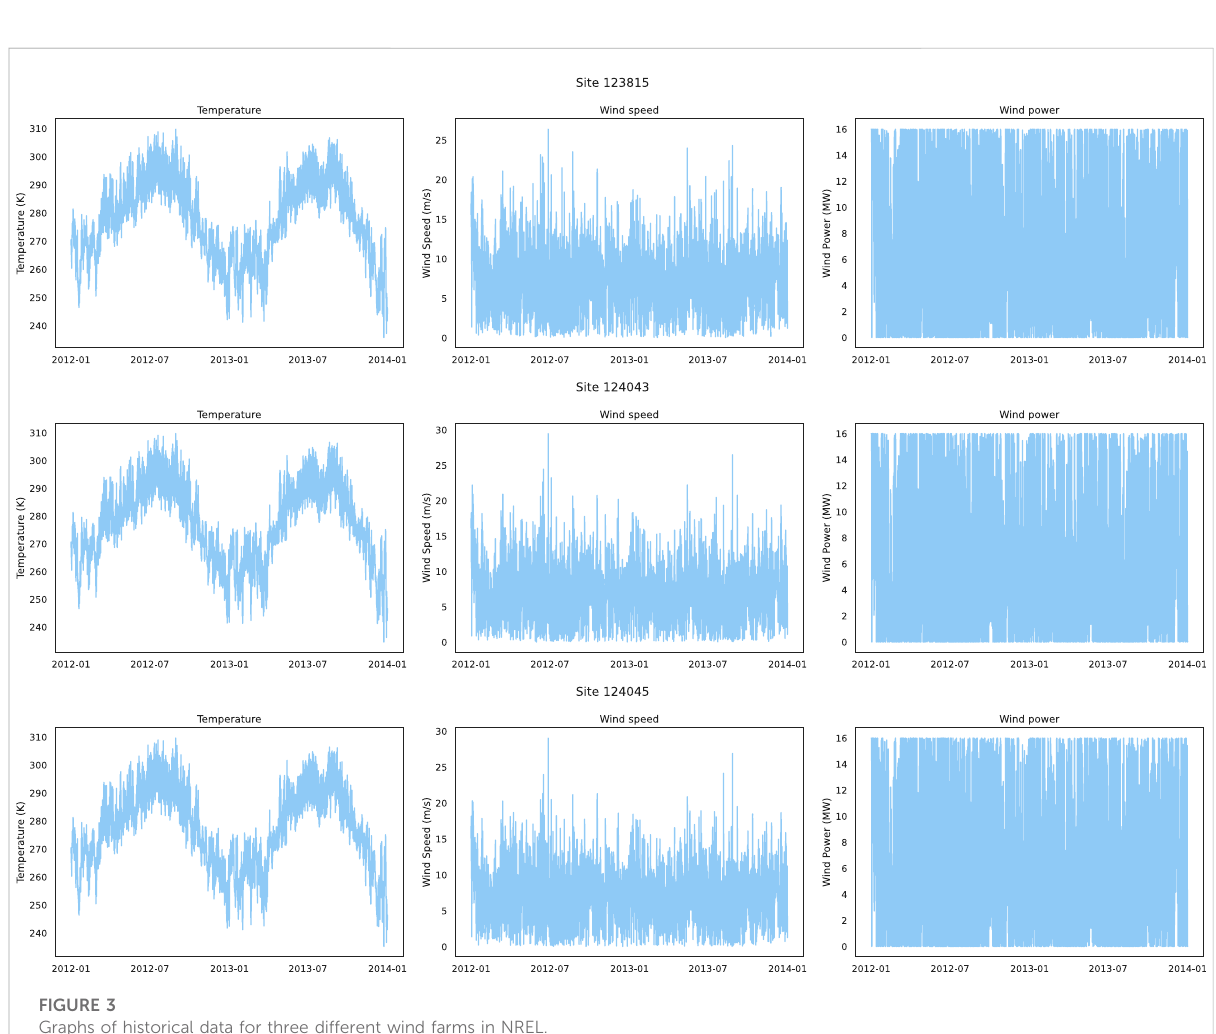
FIGURE 3 Graphs of historical data for three different wind farms in